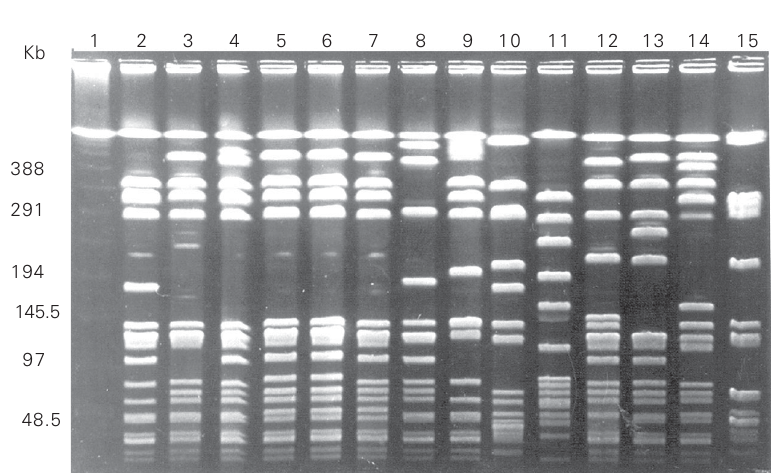
Figure 1. Pulsed-field gel electrophoresis profiles of genomic DNA from methicillin- resistant Staphylococcus aureus (MRSA) strains isolated from patients with hospital infection from April 1991 to February 1993 (period I). Lane 1 : Molecular weight marker ( λ ladder); lanes 2 , 9 , 12, and 13 : MRSA profile possibly related to the endemic profile A strain; lanes 3 , 4, and 14 : MRSA profile closely related to the endemic strain; lanes 5 , 6, and 7 : profile A (endemic strain); lanes 8 , 10 , 11 , and 15 : profiles E, D, C, and B, respectively.